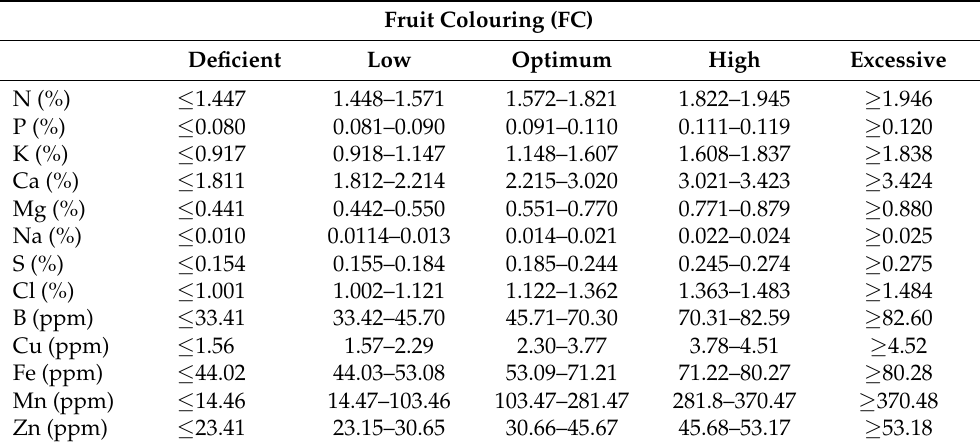
Table 6. Nutrient optimal range (NOR) in the FC of persimmon fruit in PDO ‘Kaki Ribera del X ú quer’, Spain.